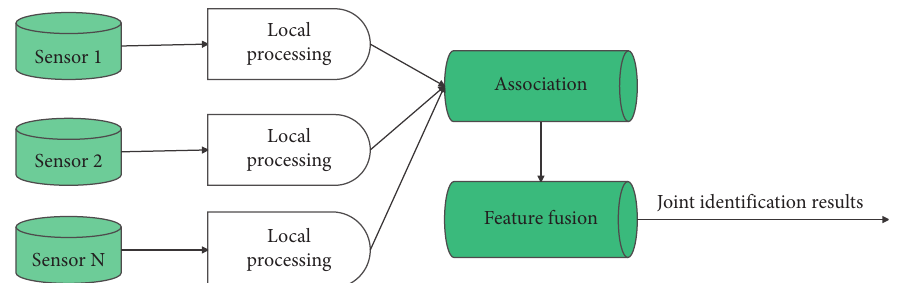
Figure 3: Block diagram of decision-making layer fusion